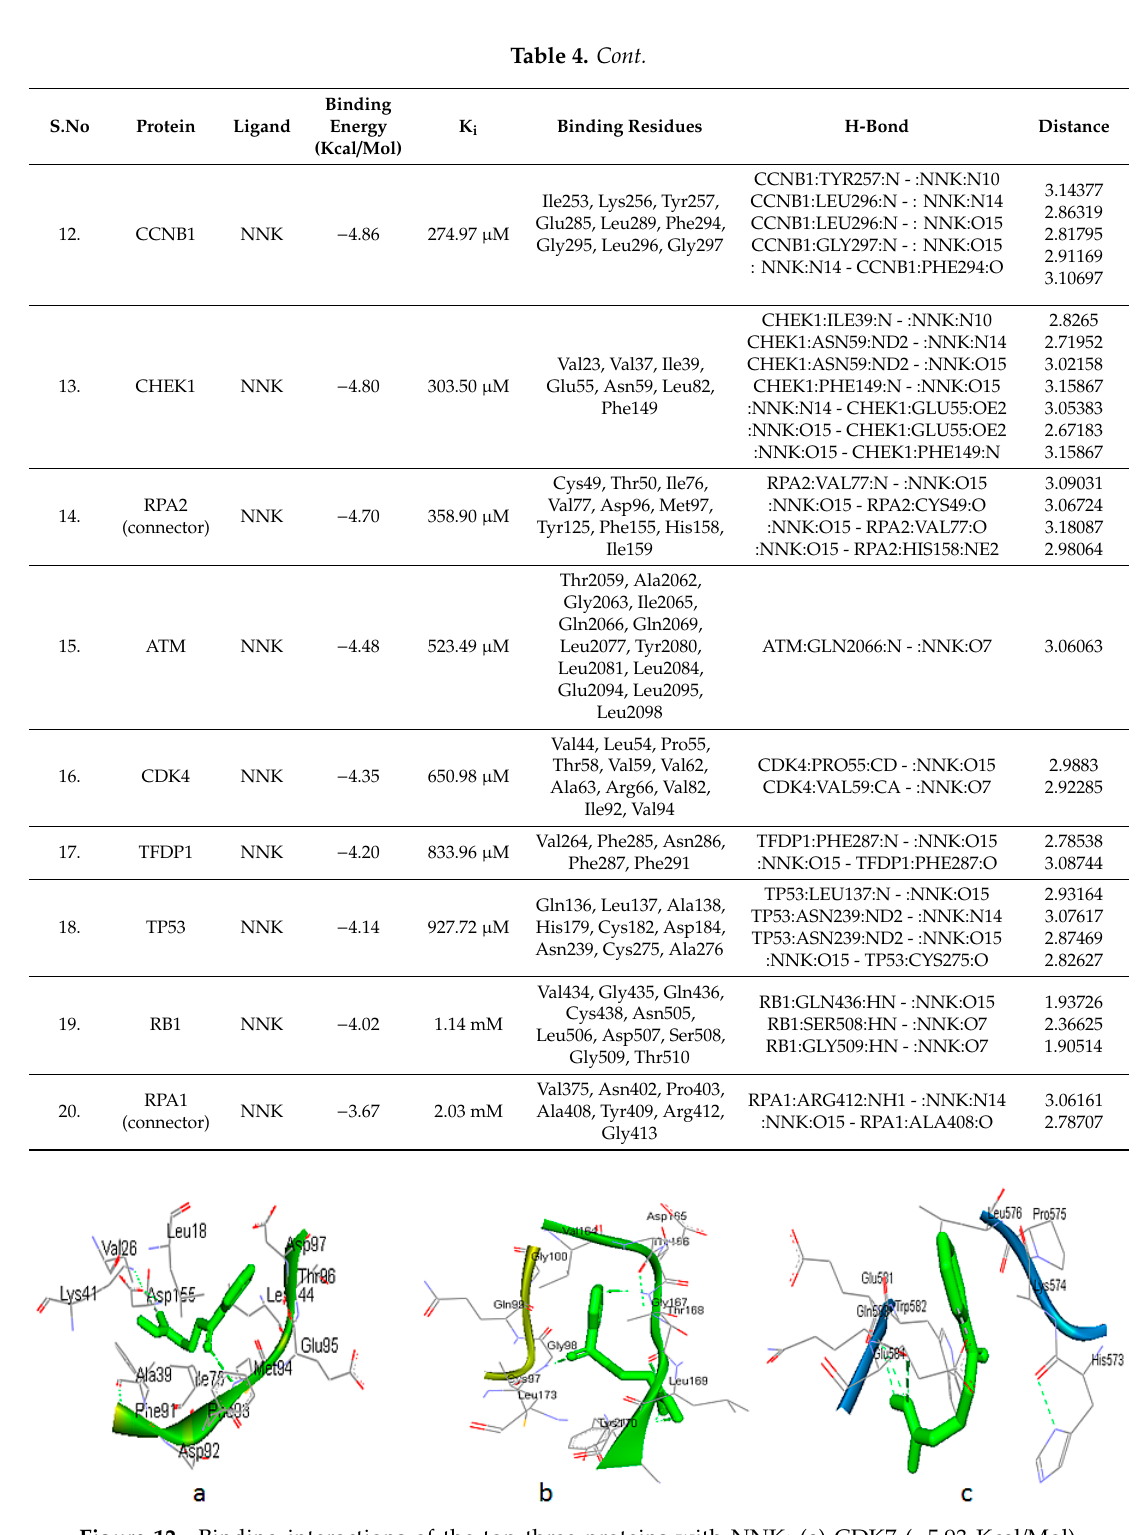
Figure 12. Binding interactions of the top three proteins with NNK: ( a ) CDK7 ( − 5.93 Kcal / Mol), ( b ) CCNA1 ( − 5.6 Kcal / Mol), ( c ) CDKN1B ( − 5.42 Kcal /